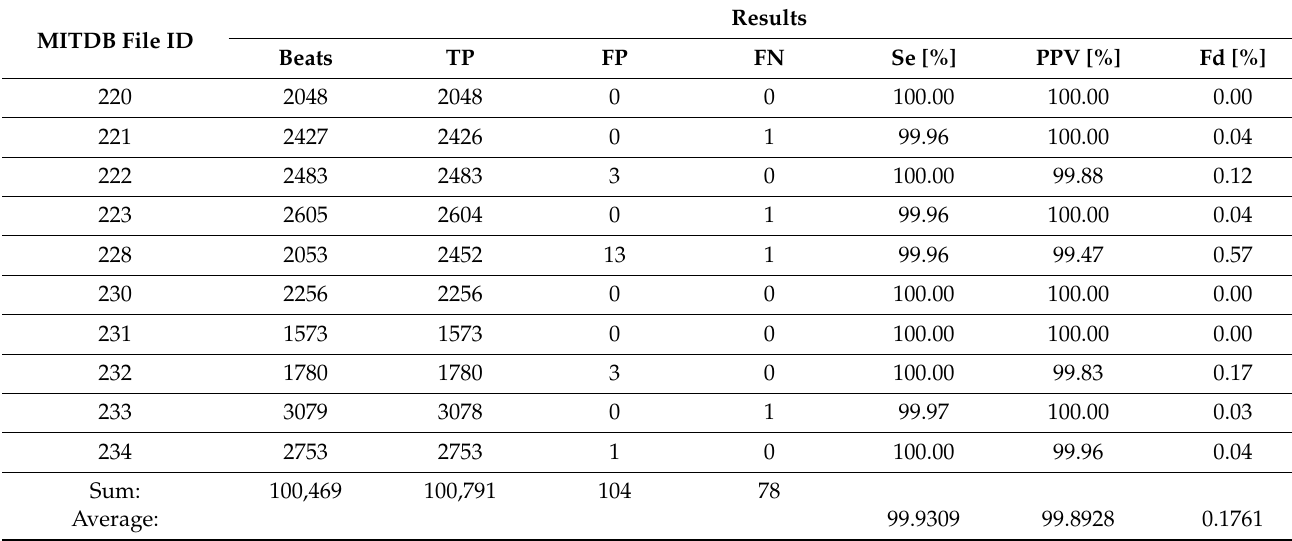
Table 3. Performance of the proposed algorithm with nECG records compared to selected other work.